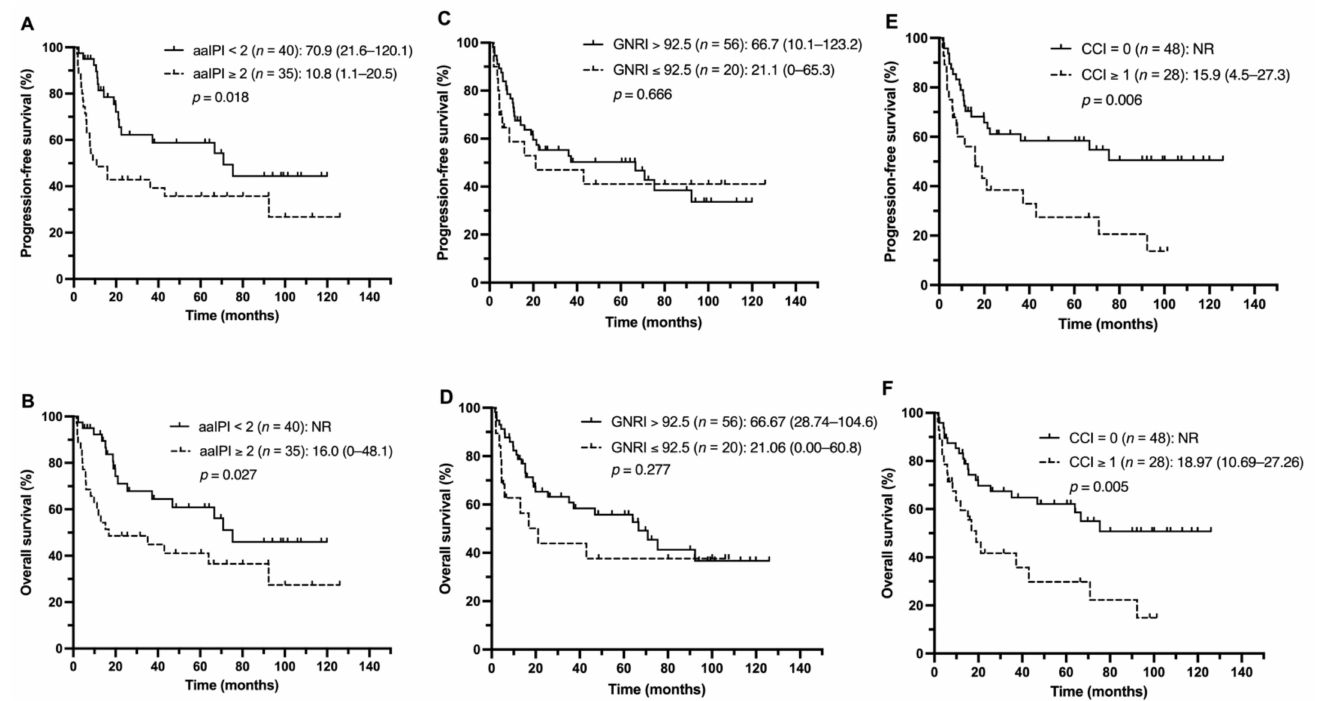
Figure 2. PFS and OS of the R–CHOP group stratified by the aaIPI ( A , B ), GNRI ( C , D ), and CCI ( E , F